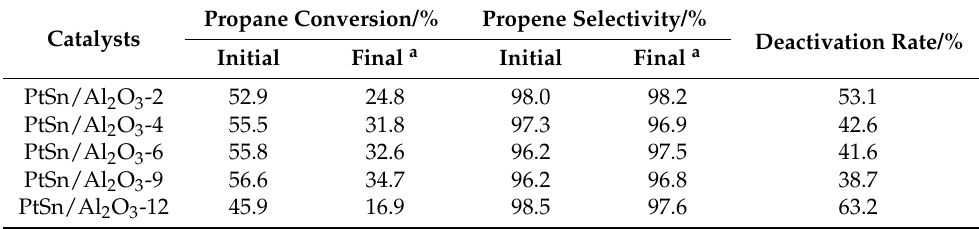
Figure 6. Catalytic performance of PtSn/Al 2 O 3 catalysts for PDH. ( A ) Propane conversion and ( B ) propene selectivity as a function of time during PDH; ( C ) TOF and deactivation rate constant ( k d ) of PtSn/Al 2 O 3 catalysts; ( D ) Catalytic performance on PtSn/Al 2 O 3 -9 catalyst for four successive PDH cycles. Table 2. Catalytic performances of PDH over PtSn/Al 2 O 3 catalysts.